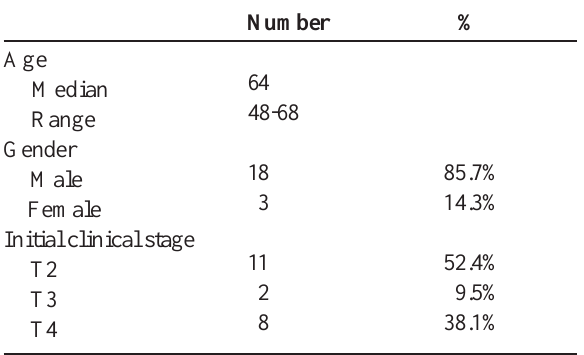
Table 1 – Baseline characteristics.